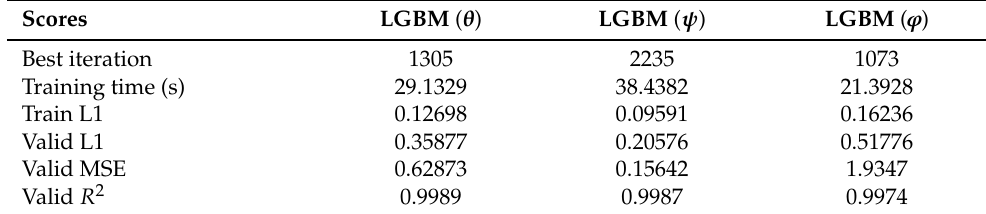
Table 4. Training results of LightGBM model for single-view